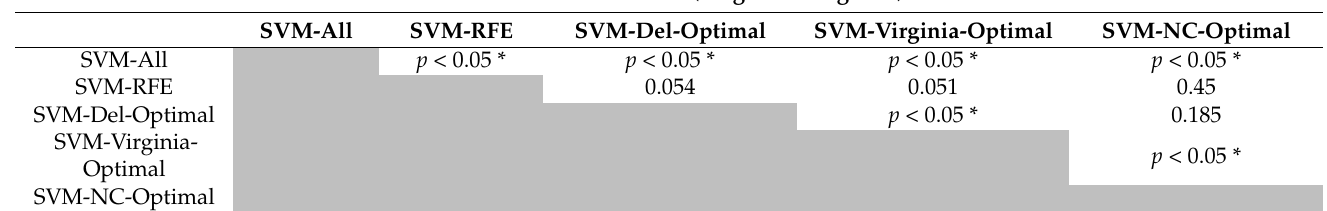
Table A4. Paired t -test p -values for Delaware classifications trained from the large training sets. (* In- dicates at a 95% confidence that the differences in mean classification accuracies between classification groups are statistically significant, p <